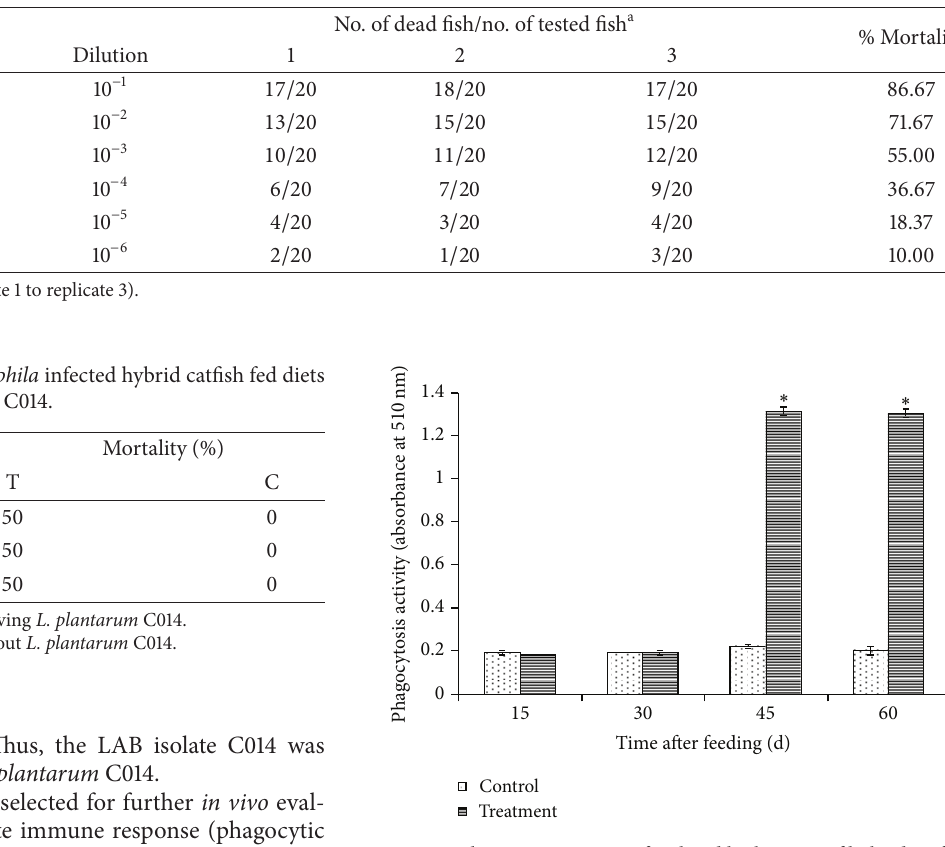
Table 1: Mortality of hybrid catfish in the first 2 weeks after intraperitoneal injection of different dilutions of A. hydrophila suspension. A . hydrophila